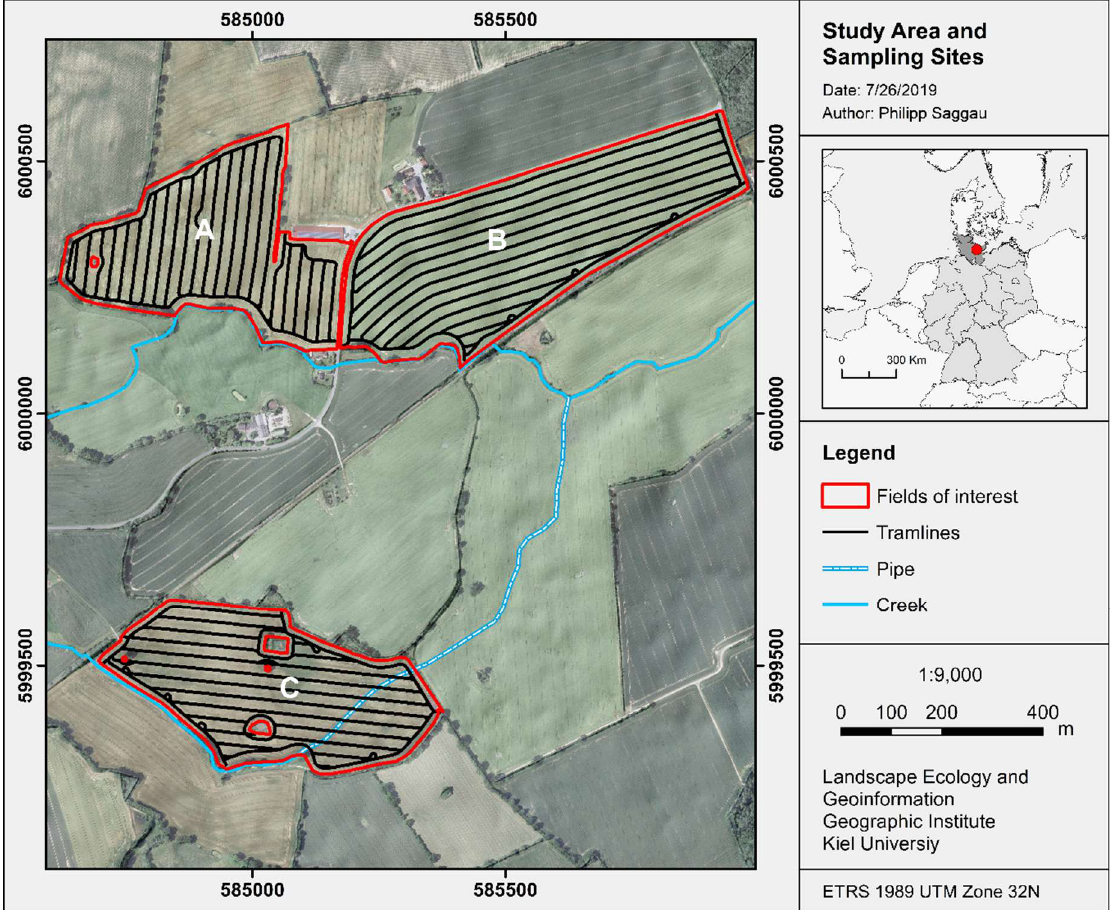
Figure 1. Study area with investigated fields for the Mühlenbach catchment in Schleswig-Holstein, Germany (Data: Orthophoto [52] , Nuts1 [53]).